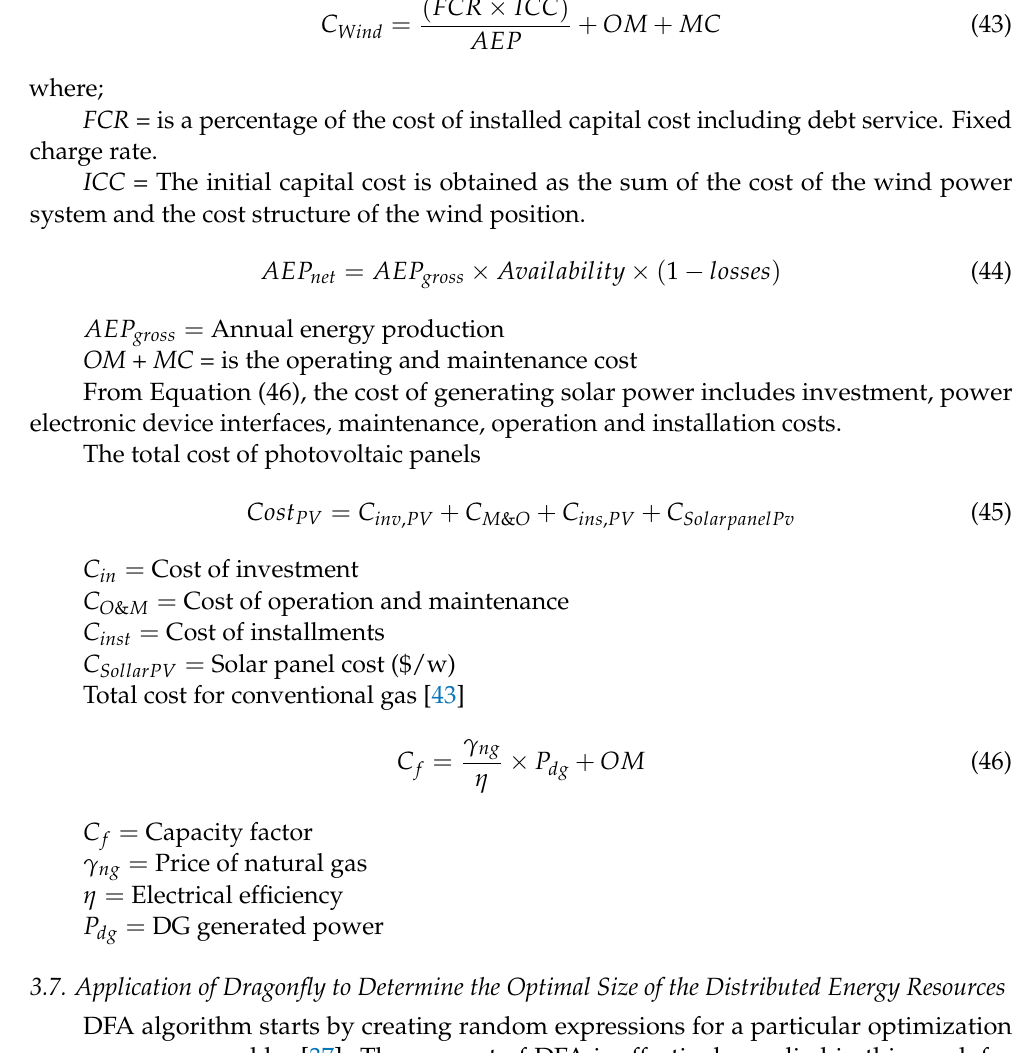
Algorithm 1. Described application of the dragonfly algorithm in optimal sizing of our Distributed system